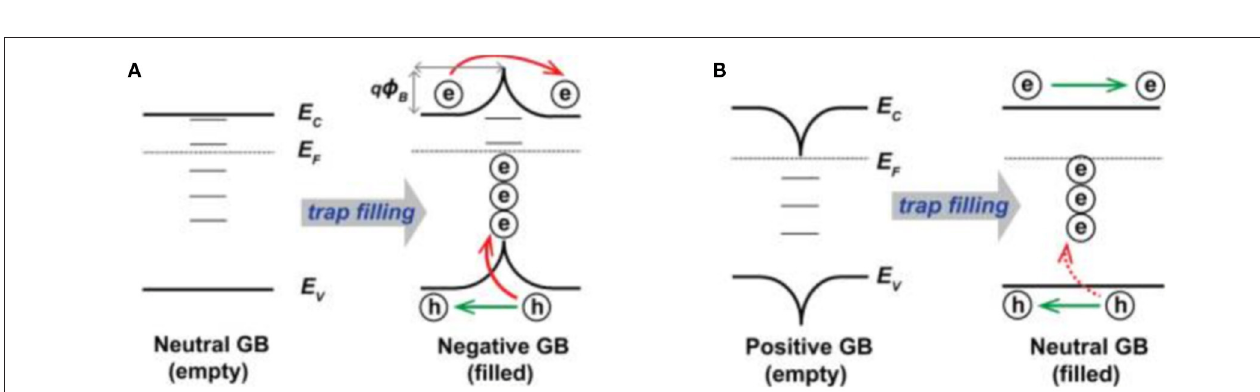
FIGURE 7 | Electronic structure (conduction and valence bands with defect levels) of typical semiconductor with the direct band gap (left) and MAPbI 3 (right) . [Reprinted with permission from Brandt et al. (2017)].